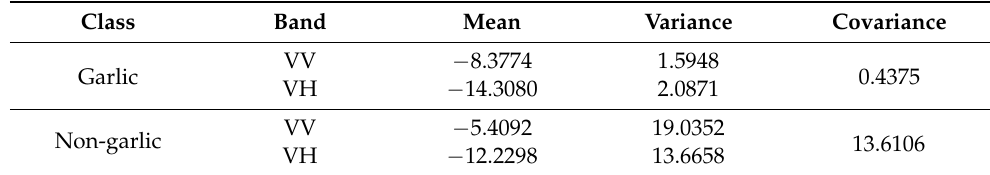
Table 5. Characteristics of bands VH and VV in dataset A.